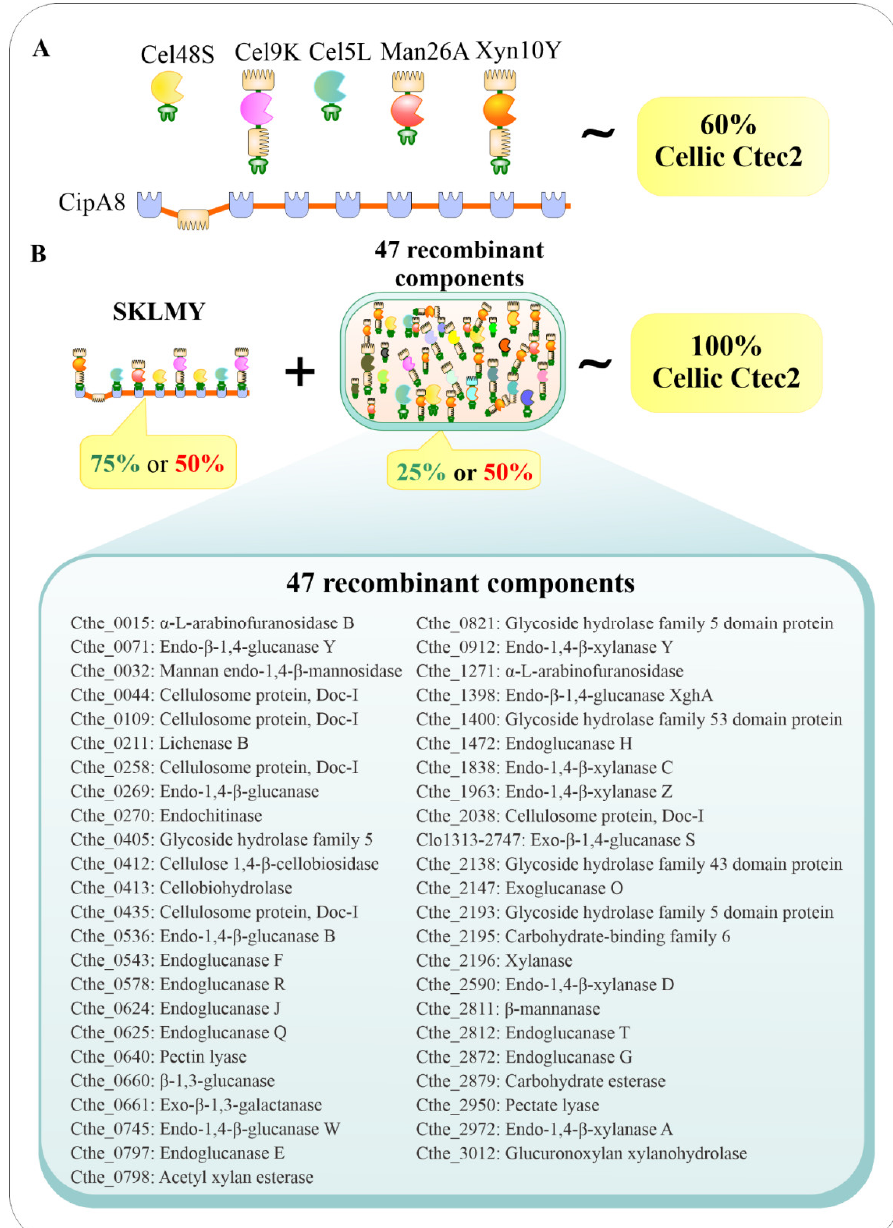
Figure 2. Construction of artificial cellulosome from a pool of recombinant cellulosomal enzymes from C. thermocellum . ( A ) The SKLMY complex with only 5 recombinant cellulosomal proteins exhibits 60% of catalytic efficiency as compared to the commercial Cellic Ctec2 cocktail. ( B ) The mixture of SKLMY complex and 47 recombinant enzymes at different ratios expresses a comparative catalytic efficiency with the commercial Cellic Ctec2.